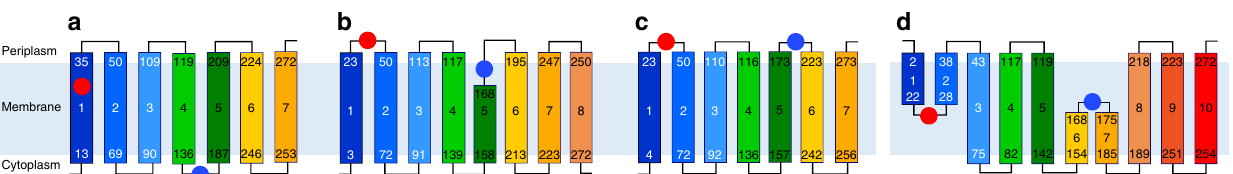
Fig. 2 Proposed topology models. a The earliest proposed topology was based on a bioinformatics investigation, which concluded that the enzyme had seven membrane helices, a cytoplasmic N-terminus and an active site facing the cytoplasm 61 . The putative active site included the BacA2 sequence motif while the conserved BacA1 region mapped to the fi rst membrane helix and was proposed to be involved in catalysis and in substrate speci fi city. b The second proposed model relied on bioinformatics, modeling, and functional and site-directed mutation work employing constructs of BacA fused with bacteriorhodopsin and green fl uorescent protein 19 . This led to the conclusion that the protein had eight membrane helices with both N- and C-termini in the cytoplasm and an outward facing active site. c The third model involved an experimental investigation focussed on biochemistry with functional and